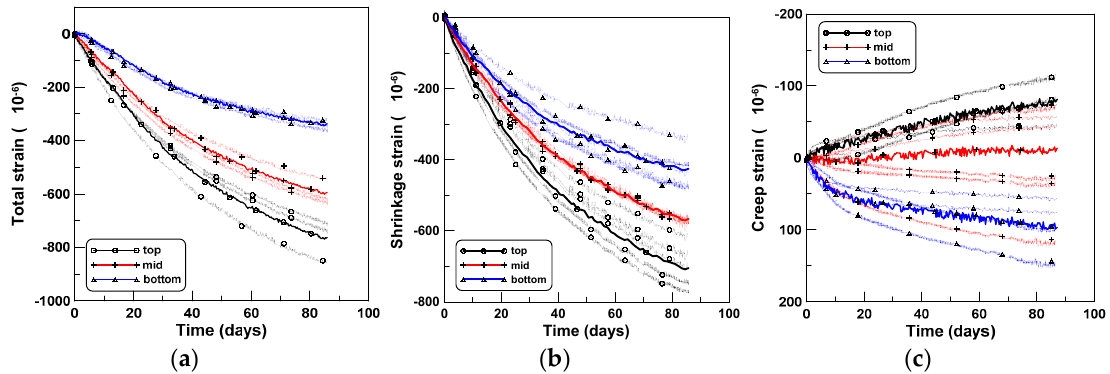
Figure 8. Strains at top, middle, and bottom surfaces (TP-2): ( a ) total, ( b ) shrinkage, and ( c ) creep.